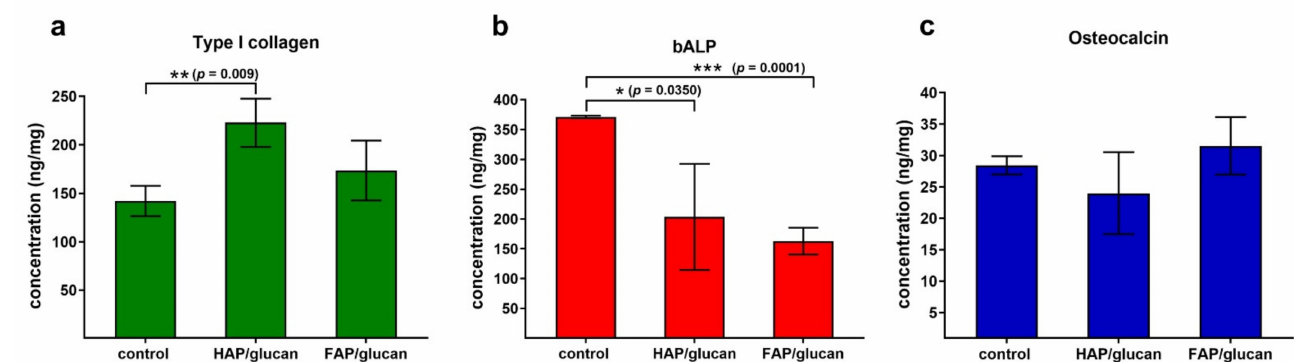
Figure 10. Osteogenic differentiation markers assessed by ELISAs for osteoblasts cultured on the biomaterials and polystyrene well as a control: ( a ) type I collagen, ( b ) bone alkaline phosphatase, ( c ) osteocalcin. The level of osteogenic markers was normalized to 1 mg of cellular proteins (assessed by BCA assay). (*, **, *** statistically significant results according to unpaird Student’s t